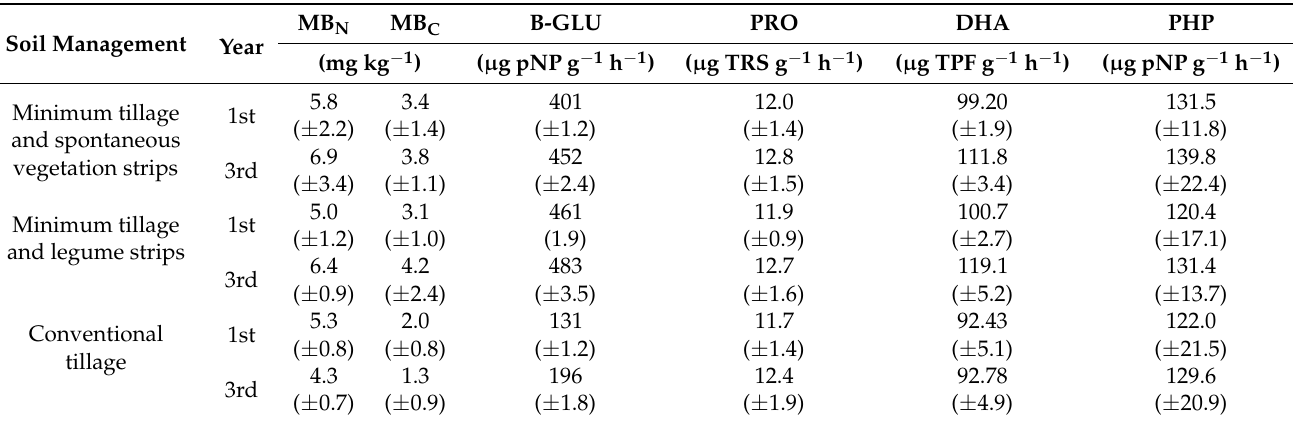
Table 4. Effect of CA practices on soil microbial and enzymatic activities in olive orchards throughout 3 year monitoring period (SE